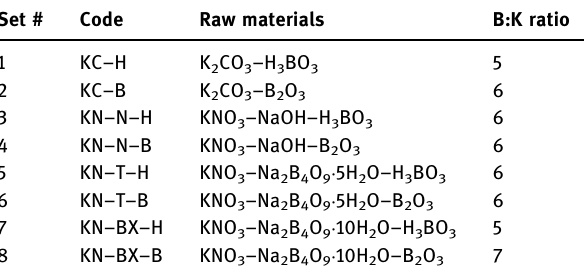
Table 3: Raw material combinations used in the ultrasonic syn - thesis of potassium borates ( Asensio et al., 2016; Dumanl ı et